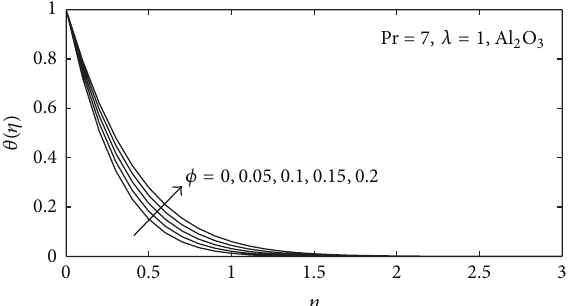
Figure 1: Temperature profiles 𝜃(𝜂) for different values of 𝜙 when Pr = 7 and 𝜆 = 1 using Al 2 O 3 nanoparticle.